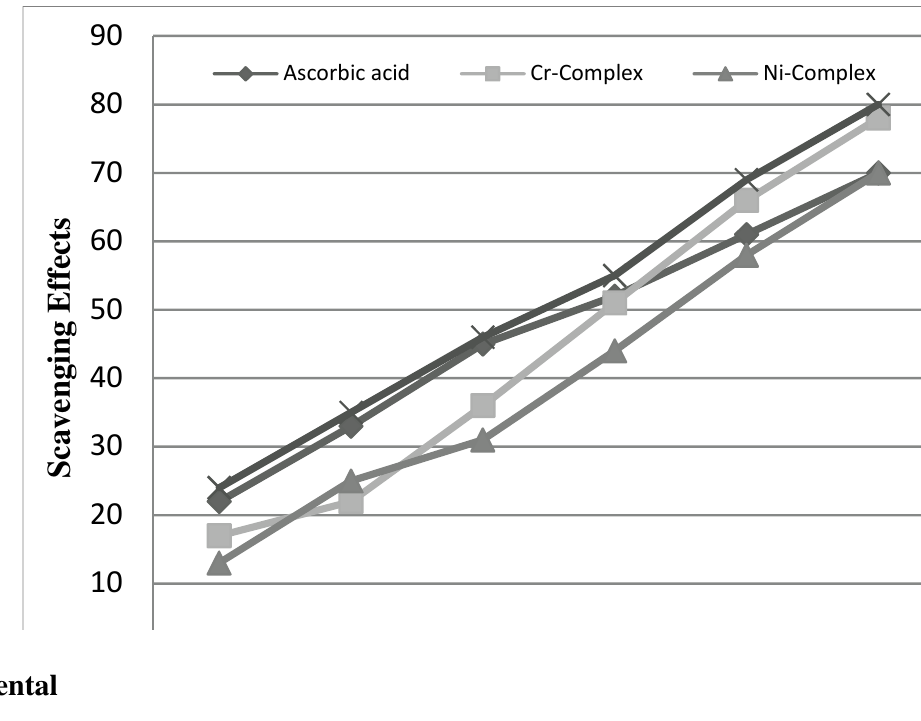
Figure 9. Scavenging effect of metal complexes, and ascorbic acid at different concentrations (15, 30, 45, 60, 80 and 100 µ